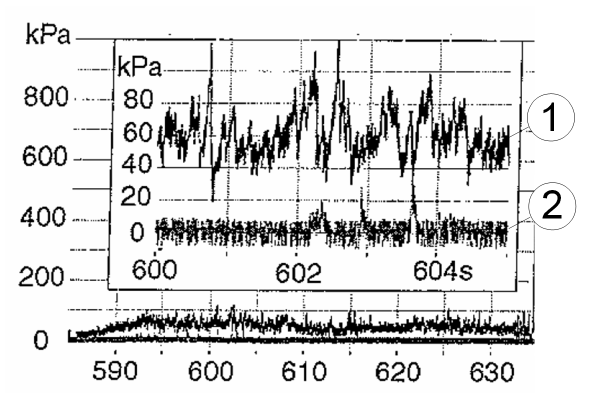
Fig. 3. Time evolution of two pressure sensors lying at 0.9m (plot 1) and 2.1m (plot 2) above the snow cover level (Schaer and Issler,